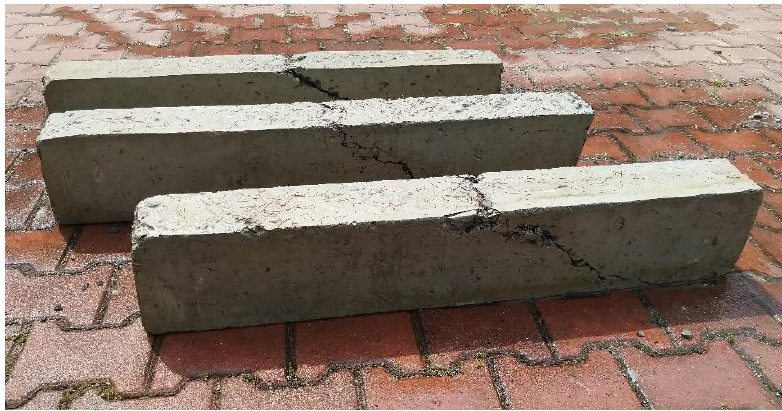
Figure 20. Reinforced concrete ( RC) Beams with shear crack.